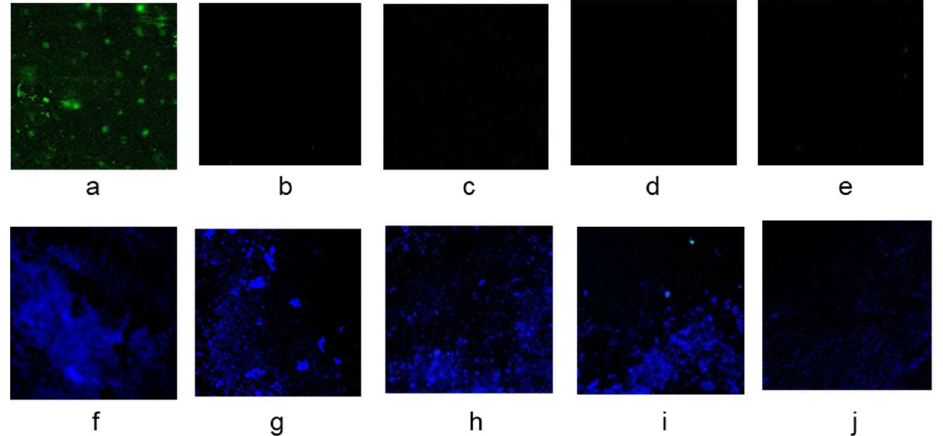
Figure 7. Fluorescence microscopy results after in situ hybridization of the specific probes with S. aureus ( a ), S. Typhimurium ( b ), L. monocytogenes ( c ), E. coli ( d ), and V. parahaemolyticus ( e ) followed by DAPI staining ( f–j ).